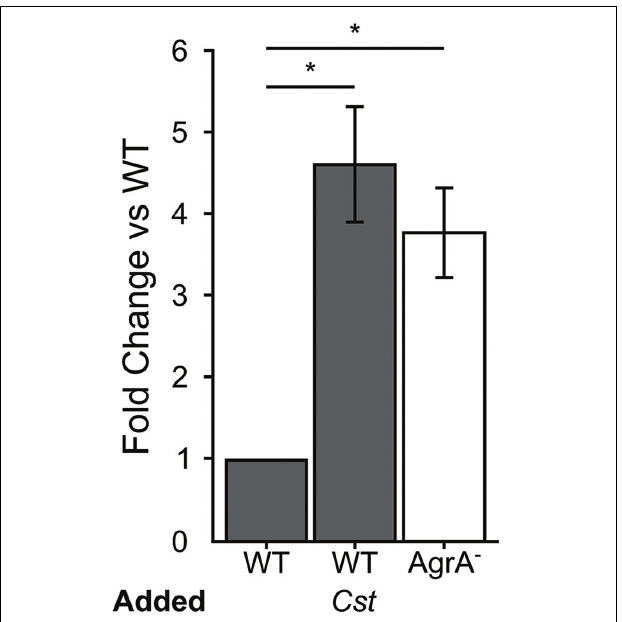
FIGURE 2 | Staphylococcus aureus attachment to human epithelial cells increases in response to C. striatum CFCM. When S. aureus WT (gray bars) and AgrA − (white bar) cells were exposed to AIP-1 plus or minus C. striatum CFCM ( Cst ), we observed 4.5- and 3.6-fold increases in attachment respectively. These increases were statistically significant ( ∗ ) when compared to the WT alone. S. aureus attachment to human A549 epithelial cells was quantified after 1 h of exposure. Attachment was measured as the percentage of attached cells divided by the total number of S. aureus planktonic cells added, as determined by CFU enumeration. Fold change was determined by dividing the percent attached for each condition by that of the % attached for WT exposed only to AIP. Error bars were omitted from the WT normalized data for clarity. Data were analyzed by two-tailed Student’s t -test with Bonferroni correction for multiple testing ( ∗ p < 0.03). Error bars represent